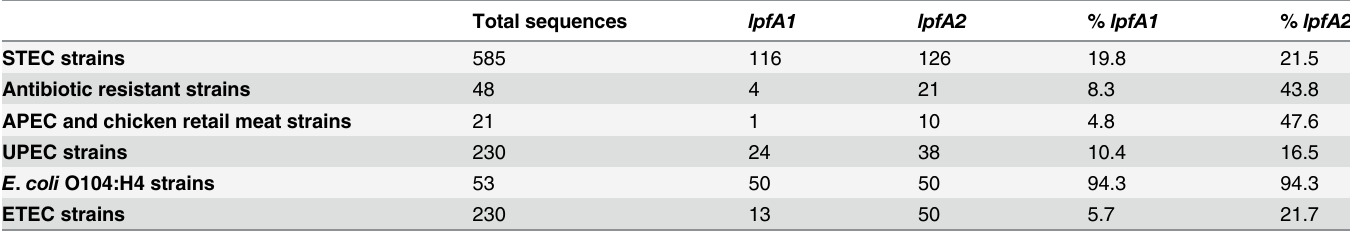
Table 2. Distribution of E . coli O104:H4 lpfA gene homologues among different E . coli